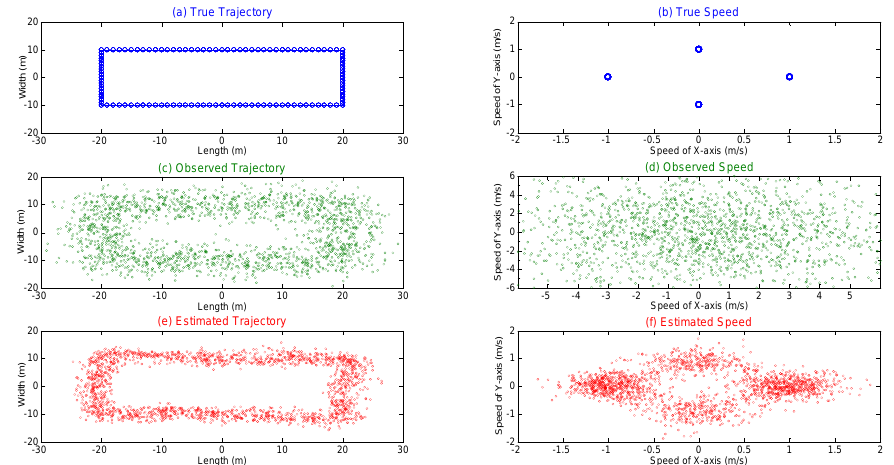
Figure 10. Software simulation results for the tracking location and speed of an MD based on α - β tracking approach as the MD moves the clockwise direction of the path in a plane of indoor environments ( a , b ) original trajectory and speed; ( c , d ) observed trajectory and speed (positioning approach); ( e , f ) estimated trajectory and speed.